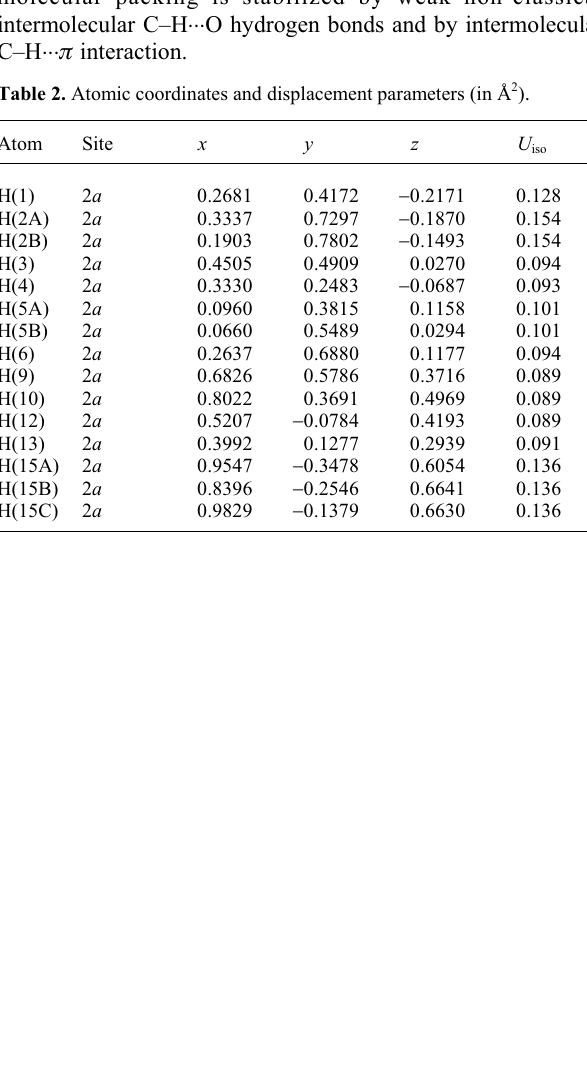
Table 1. Data collection and handling.